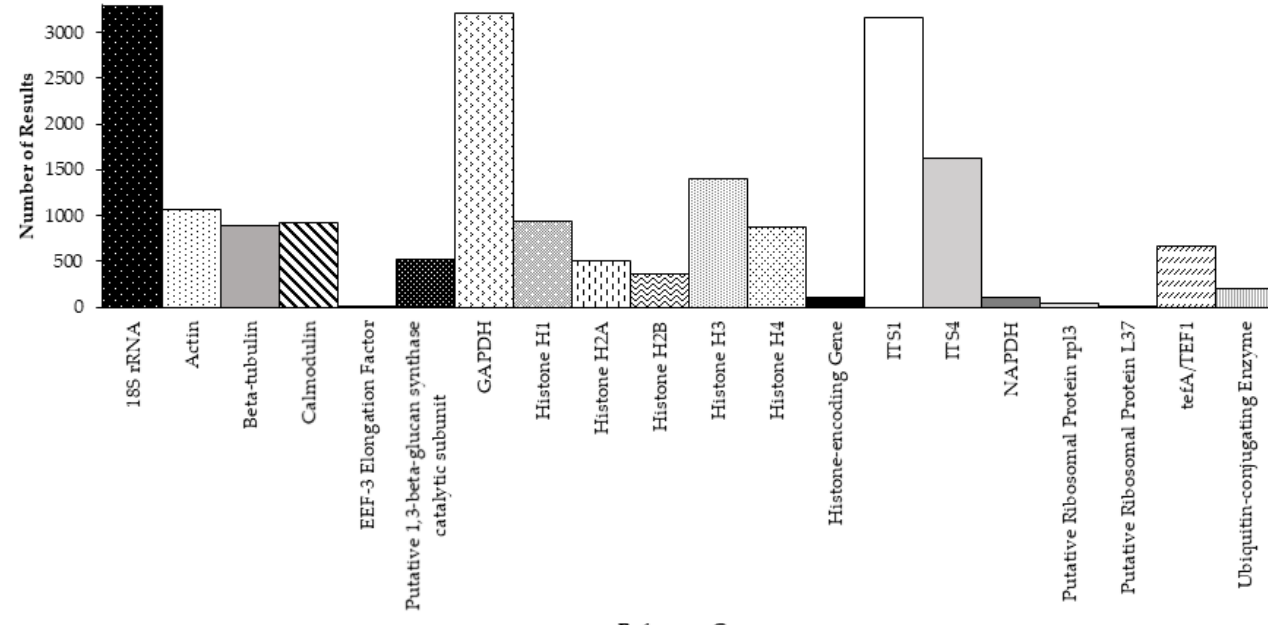
Figure 2. Number of search results for each reference gene based on their corresponding Google Scholar query. The 18S rRNA reference gene returned the most results, with 3290 results returned.